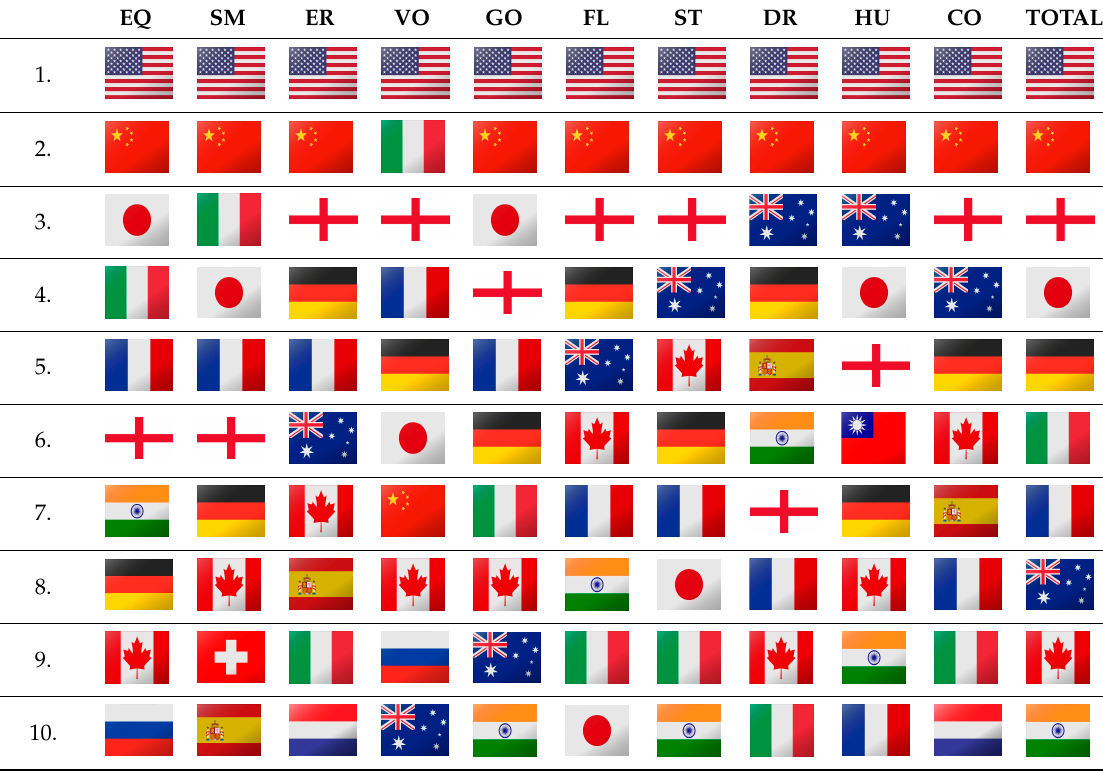
Table 4. Top 10 research countries for individual types of natural hazard (see Table 1 for abbreviations).